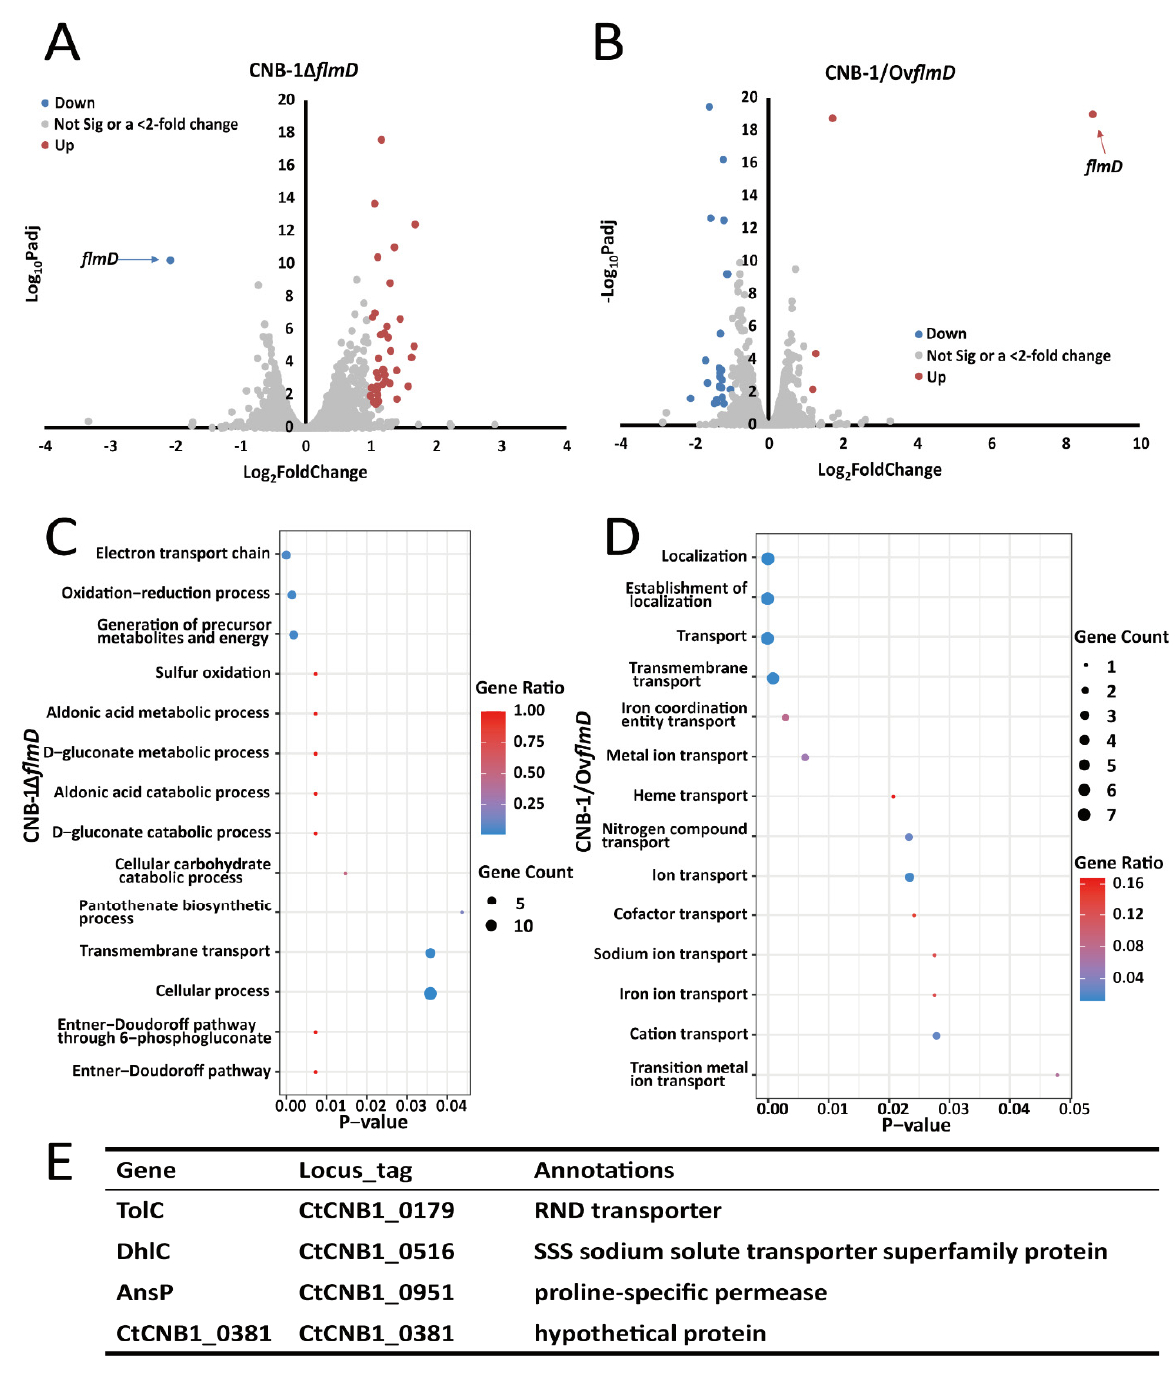
Figure 1. FlmD negatively regulates the transcription of transporters in C. testosteroni . ( A ); and ( B ) Comparative transcriptome analysis among CNB-1, CNB-1 Δ flmD , and CNB-1/Ov flmD revealed that FlmD negatively regulated a small number of genes. Color scheme: red dots, genes showing significant and >2-fold upregulation; gray dots, genes showing no significant or <2-fold change; and blue dots, genes showing significant and >2-fold downregulation. Padj: p -value adjusted for multiple testing with the Benjamini–Hochberg procedure to control the false discovery rate; ( C ) and ( D ) Gene ontology terms in biological process categories associated with material transport were enriched; ( E ) Four genes show significant and >2-fold change in both strains CNB-1 Δ flmD and CNB-1/Ov flmD .